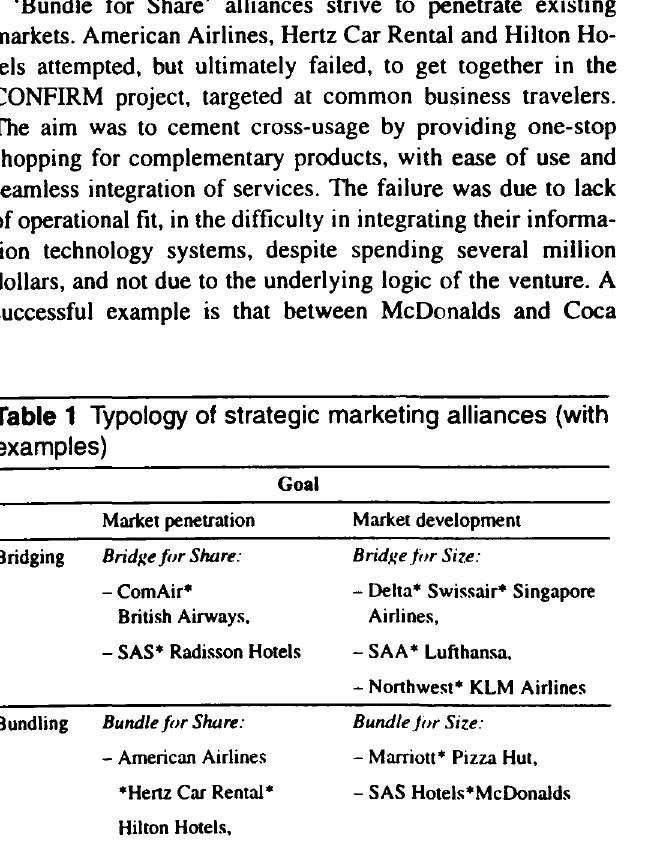
Figure 1 Market-driven strategic alliance process different conditions, and careful analysis of environmental conditions is required.